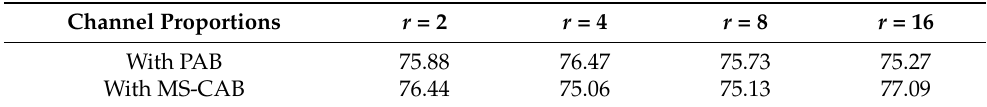
representing the values of r 1 and r 2